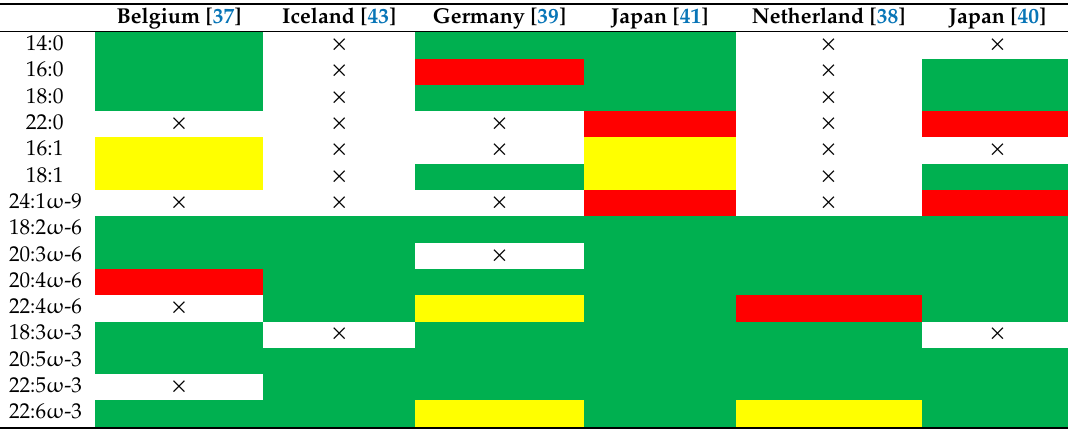
Table 4. A comparison of reported mean [37–39,43] or median [40,41] concentrations (%) of fatty acids in di ff erent countries with those selected in the present study. The symbol × indicates that the fatty acid is not reported in the particular reference number. The green, yellow and red colors denote: Between 2.5 and 97.5 percentiles, under 2.5 percentile and over 97.5 percentile of the present study,